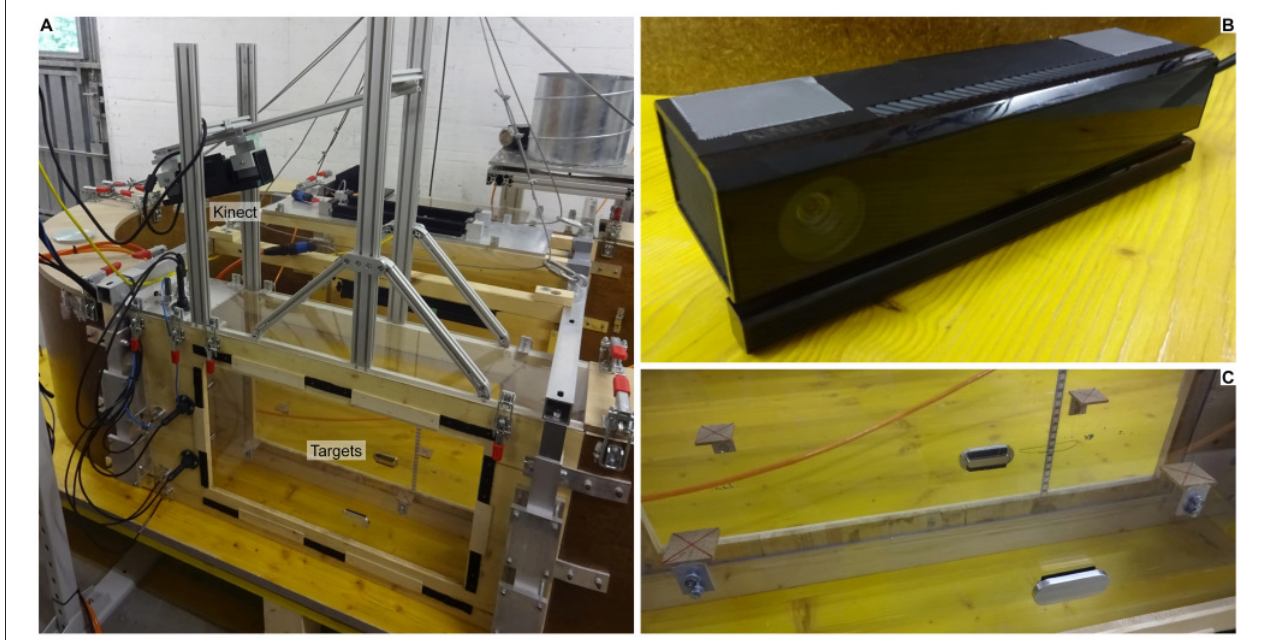
FIGURE 1 | (A) The Kinect mounted obliquely above the main test section of the wind tunnel. The modular support allowed us to find the best possible position and orientation of the Kinect in situ . Details of the Kinect sensor (B) and of the four reference targets attached to the windows of the main test section (C) . The channel in (A) is 20cm wide and 50cm high. The straight section is 1 m long.